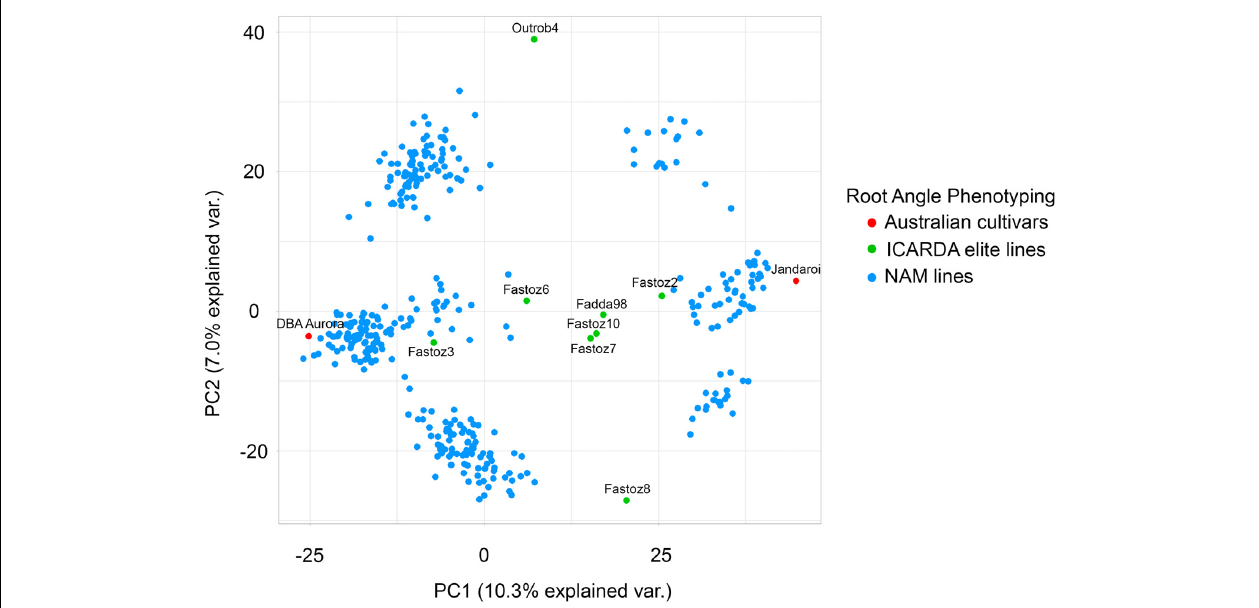
FIGURE 1 | Population structure for the durum NAM lines evaluated for seminal root angle using the clear pot method. A principal component analysis based on pairwise modified Roger’s distances calculated from 2,541 polymorphic DArTseq markers was performed for the 393 NAM lines. The ten families NAM lines are derived from two Australian reference varieties (red) and ICARDA elite lines